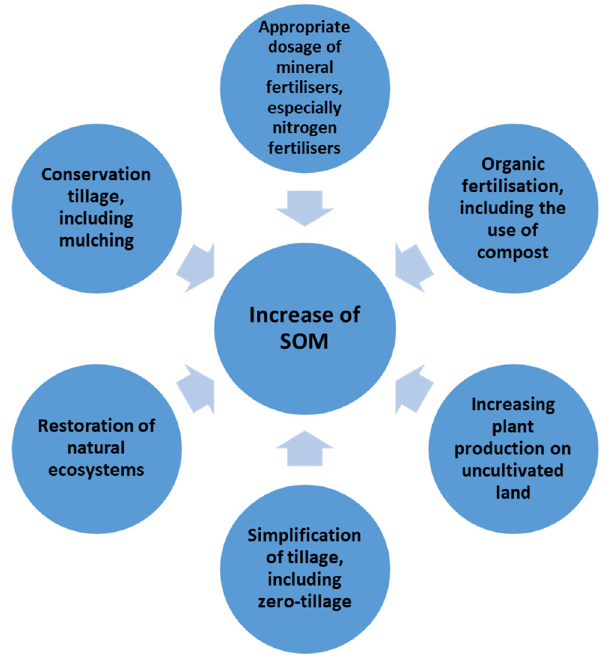
Figure 6. Methods of increasing carbon deposit in the soil